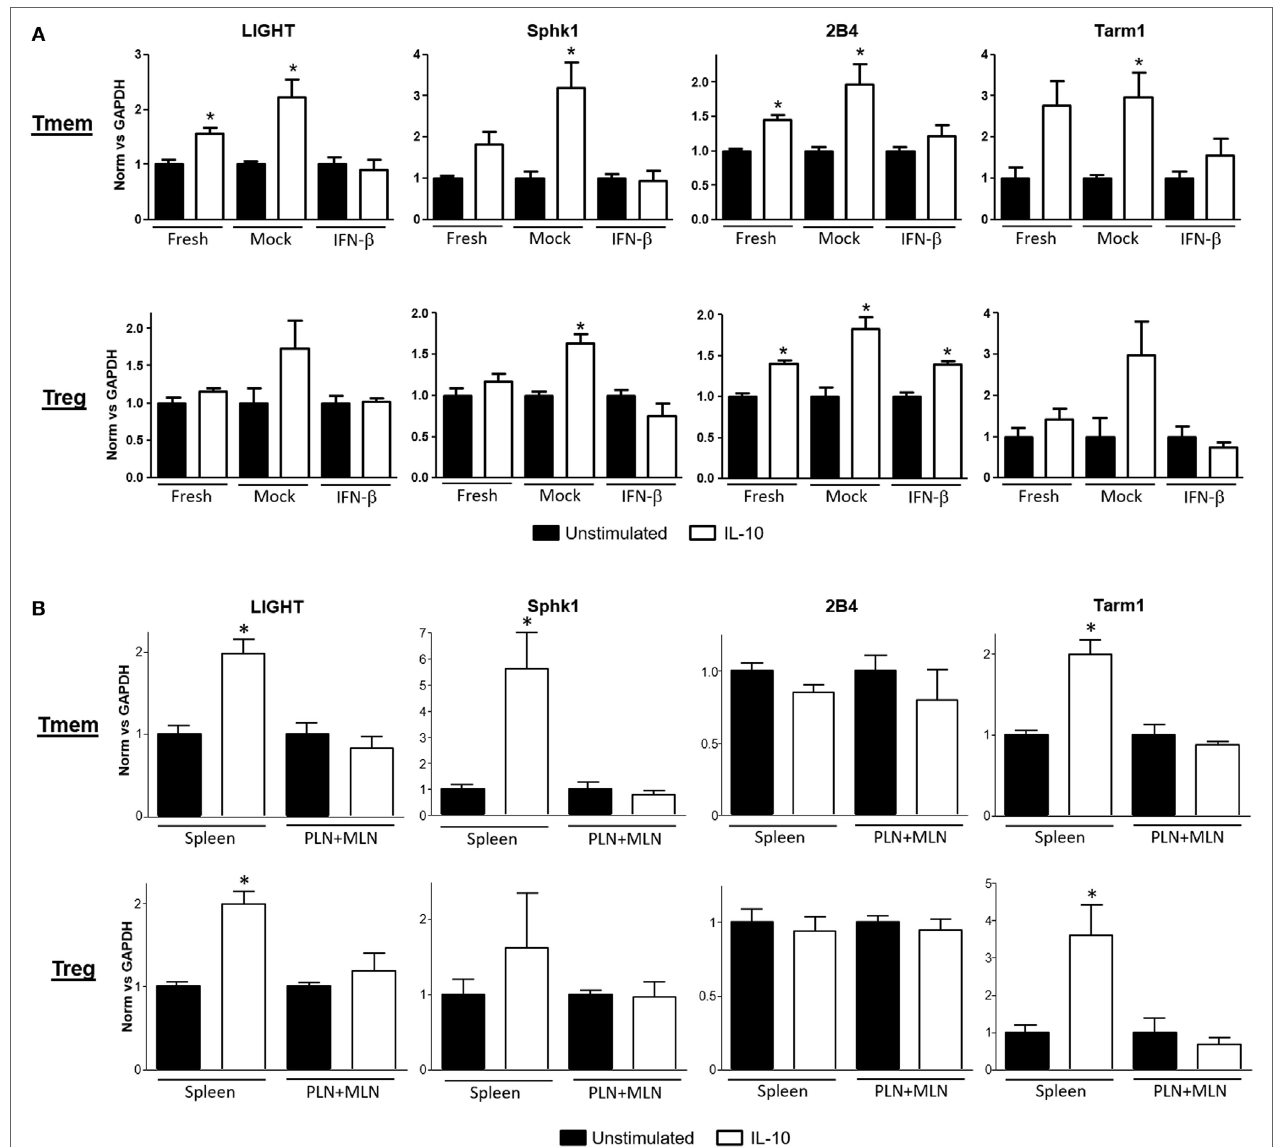
FigUre 3 | Expression of interleukin-10 (IL-10) regulated genes in T cells is abrogated after exposure to IFN- β . (a) Freshly purified CD4 memory T cells (Tmem) (obtained using the “parking method”; see Materials and Methods) and CD4 + CD25 + regulatory T cells (Tregs) from C57BL/6 mice were left untreated or cultured 48 h without (mock) or with IFN- β (5 ng/ml). After an additional 4 h of resting (without stimuli), cells were either left untreated or stimulated for 4 h with IL-10 (40 ng/ml). (B) Freshly purified Tmem and Treg (CD4 + CD25 + ) from spleen and pooled pancreatic lymph nodes (PLN) + mesentheric lymph nodes (MLN) were either left untreated or stimulated for 4 h with IL-10 (40 ng/ml). (a,B) Cells were then lysed and mRNA levels of LIGHT , Sphk1 , 2B4 , and Tarm1 genes were measured by qPCR. ΔΔ Ct method was used to calculate their relative expression and then normalized to GAPDH. The graph bars show the fold change between unstimulated and stimulated conditions in the different groups ± SEM. * p < 0.05 in unpaired Student’s t -test was considered statistically significant. Data show the average of n = 3 independent experiments (a) or n = 4 animals per group (B)